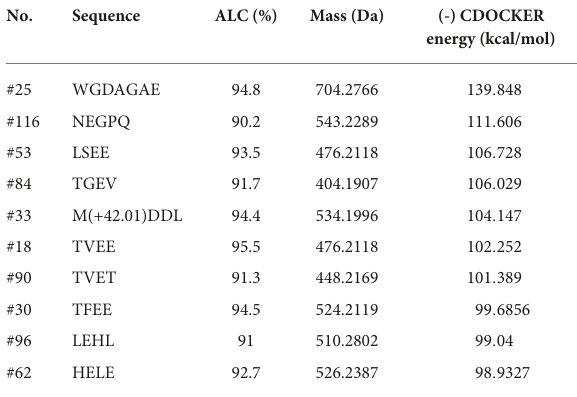
diseases through the Nrf2 signaling pathway (19, 20,